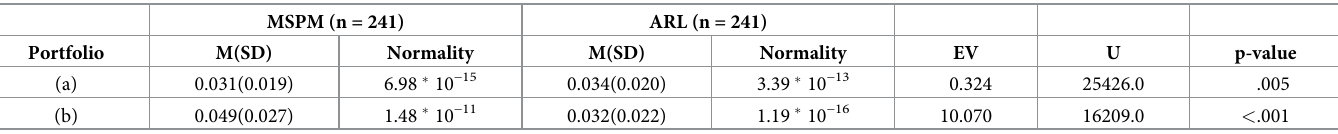
Table 4. Results of statistical test on the RstdDRR of MSPM and